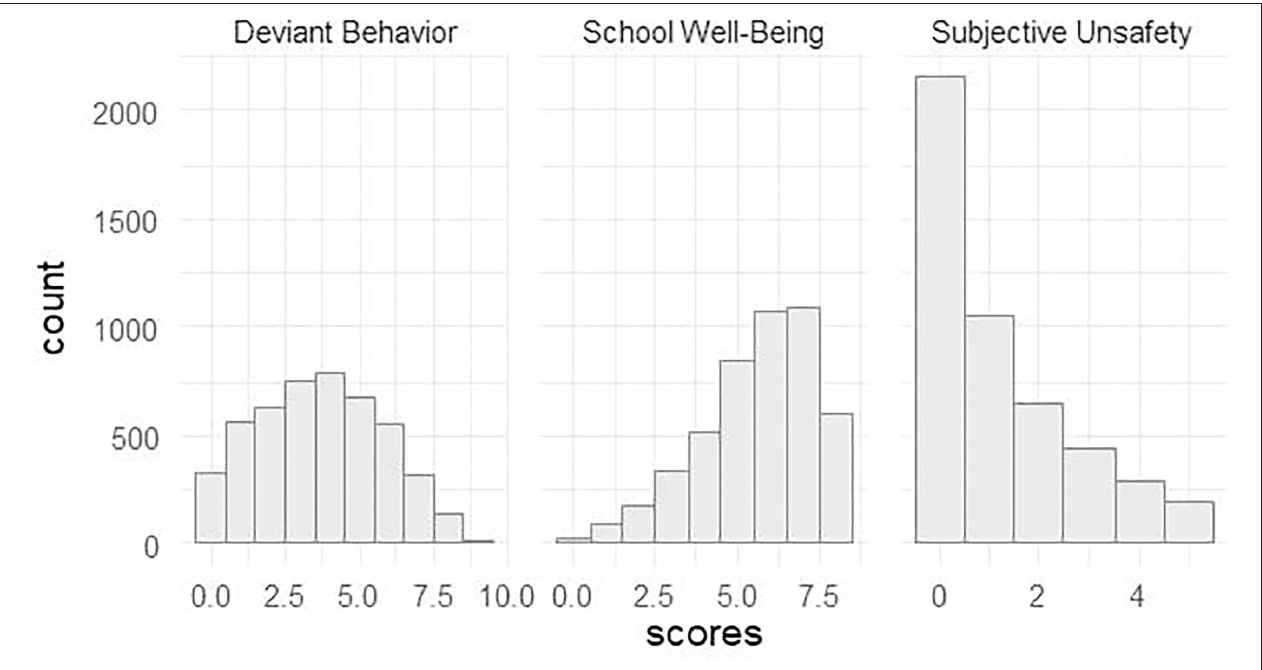
FIGURE 1 | Distribution of the scores of the scales.